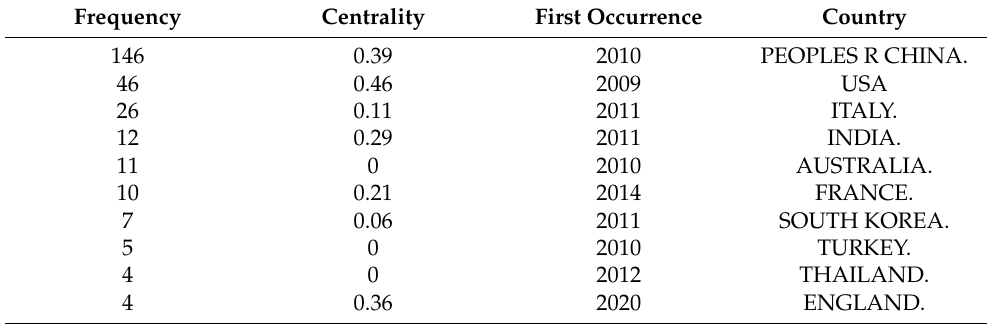
Table 2. Top 10 countries/territories in LbL self-assembly coating on fabric ranked by frequency.